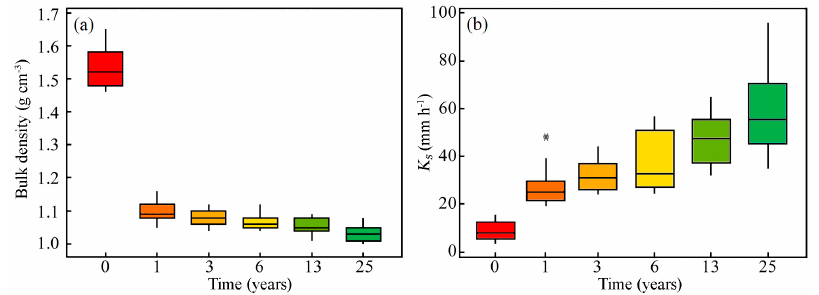
Figure 3. Box plots of ( a ) the soil bulk density (g cm − 3 ) and ( b ) the field saturated soil hydraulic conductivity ( K s , mm h − 1 ) values. Boundaries indicate median, 25th, and 75th quartiles; the top and bottom whiskers indicate the minimum and maximum values. Values beyond the whiskers are outliers. Outliers are defined as data points more than 1.5 times the interquartile range away from the upper or lower quartile.